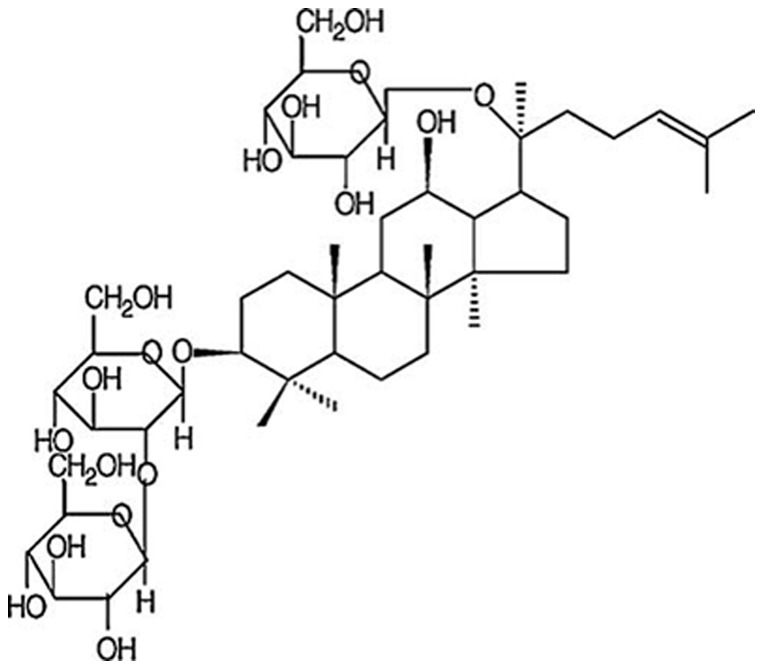
The chemical structure of GSRd.The molecular formula of GSRd (C48H82O18·3H2O). Its molecular weight is 1001.